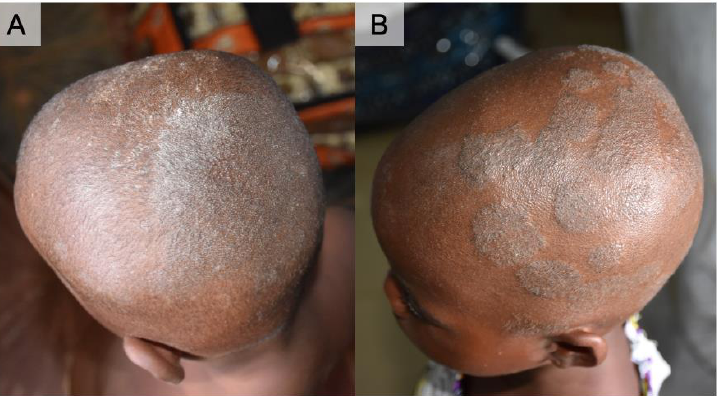
Figure 1. Clinical presentation of two cases of Microsporum audouinii. ( A ) Case 1 in a three-year-old boy. Irregular patches of whitish to silver scales with breaking hairs of the scalp. ( B ) Case 2 in a six-year-old girl. Raised and well-defined multiple patches of the scalp. She had her hair shaved as part of the treatment (local practice).